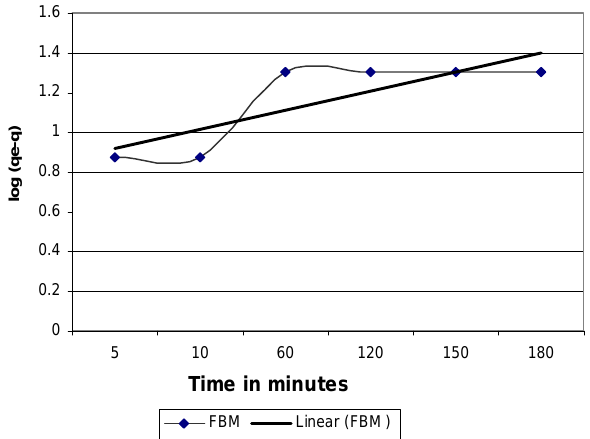
Figure 5: Lagergren equation fitting showing a linear